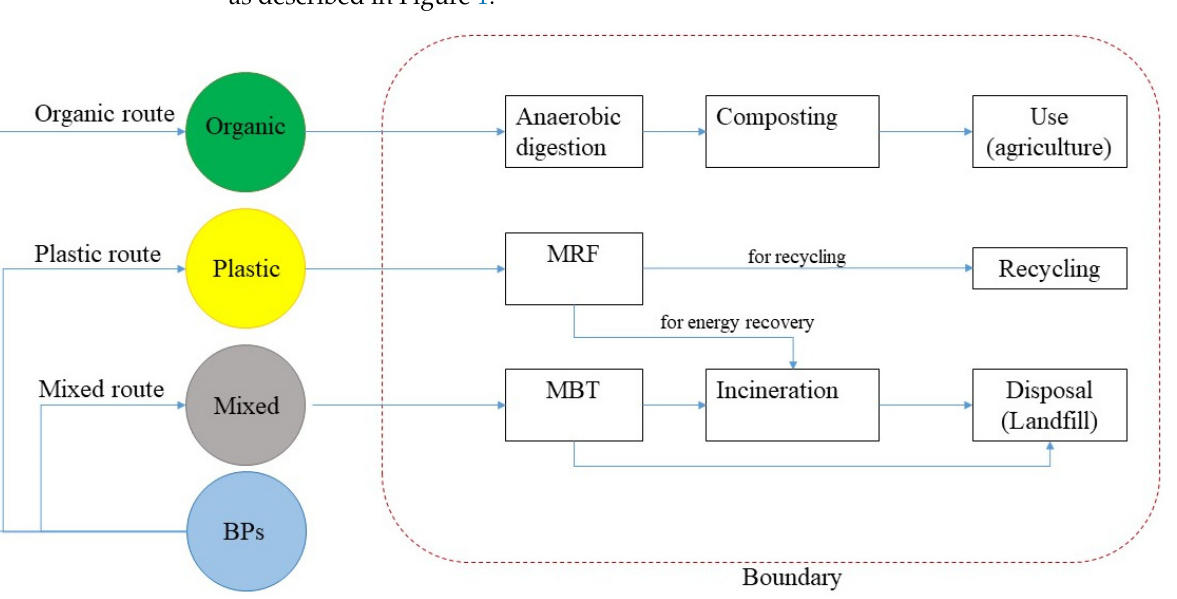
Figure 1. Scheme of the waste management system and waste treatment routes hypothesized.